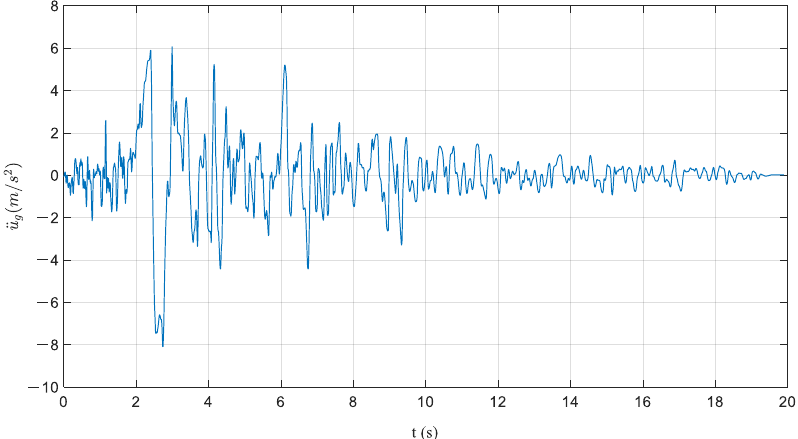
Figure 7. Time history of earthquake record ER15.